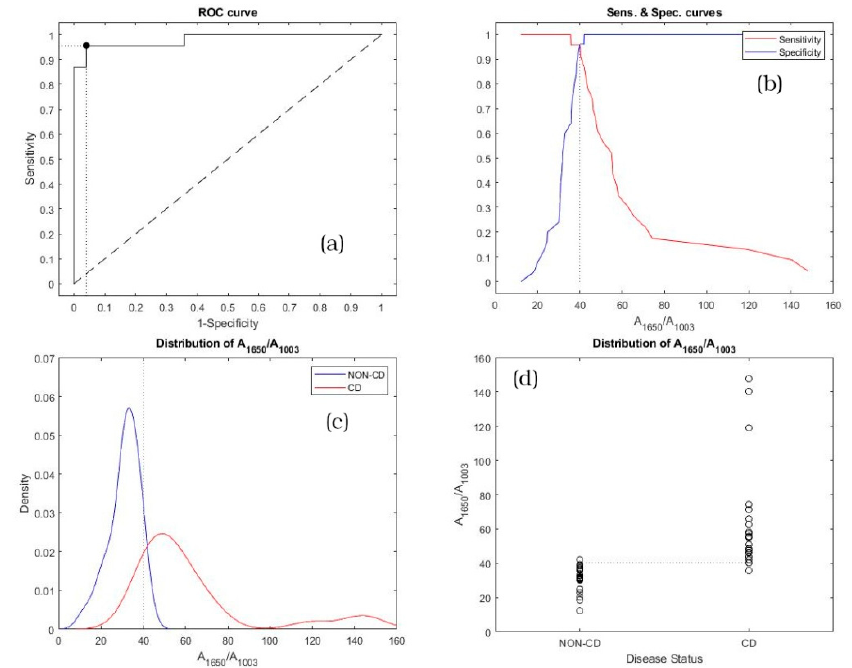
Figure 5. Statistical analysis related to the A 1650 /A 1003 ratio for non-CD and CD subjects: ( a ) ROC curve; ( b ) sensitivity and specificity vs. A 1650 /A 1003 ratios; ( c ) kernel distribution fit and ( d ) scatter distribution.